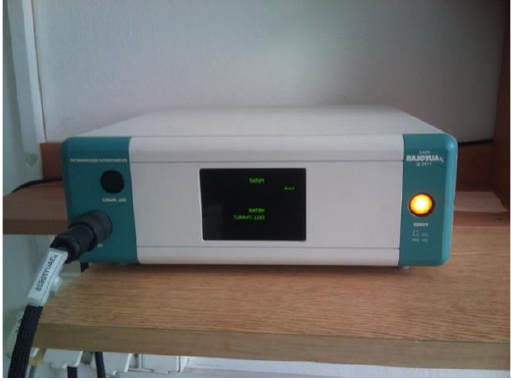
Figure 8. Potentiostat/galvanostat —μAutolab GpES.